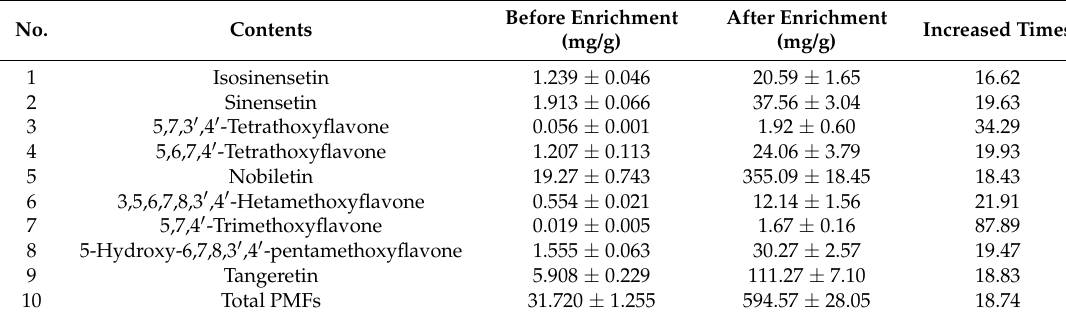
Table 5. Composition and content of PMFs of tangerine peel extracts before and after HPD 300 resin purification.